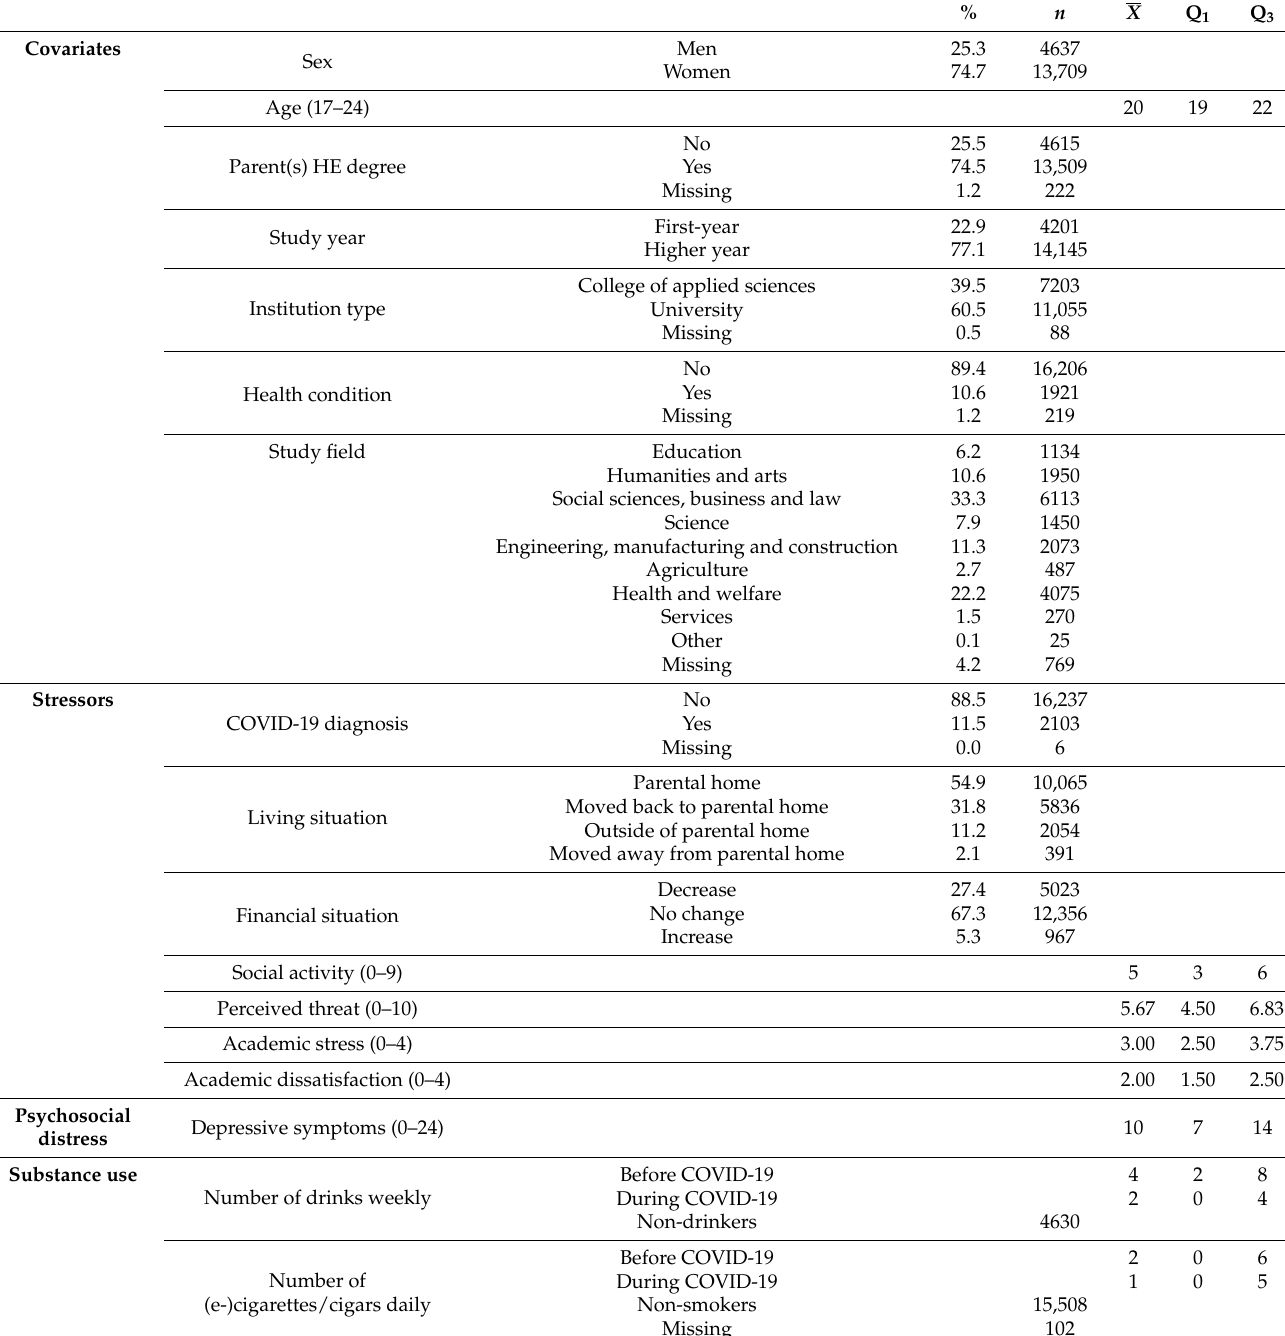
Table 1. Full information sample with percentage distributions (%) for categorical variables, and median ( X ) and Tukey’s hinges (25th percentile (Q 1 ) and 75th percentile (Q 3 )) for continuous non- normally distributed variables ( n =